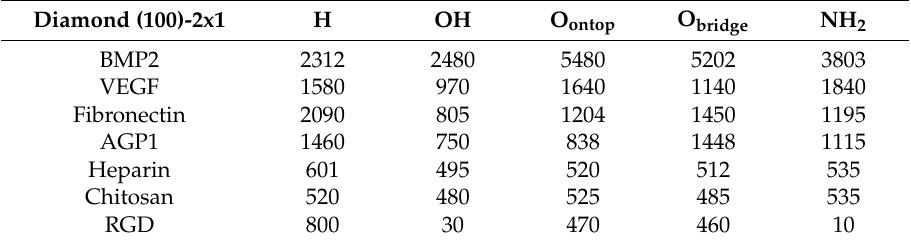
Table 1. Adhesion energy for various biomolecules attached onto an X-terminated diamond (100)-2x1 surface (X = H, OH, O ontop , O bridge and NH 2 ). The biomolecules include VEGF, BMP2, AGP1, fibronectin, heparin, chitosan and RGD. The unit is kJ/mol. Diamond (100)-2x1 H OH O ontop O bridge NH 2 BMP2 2312 2480 5480 5202 3803 VEGF 1580 970 1640 1140 1840 Fibronectin 2090 805 1204